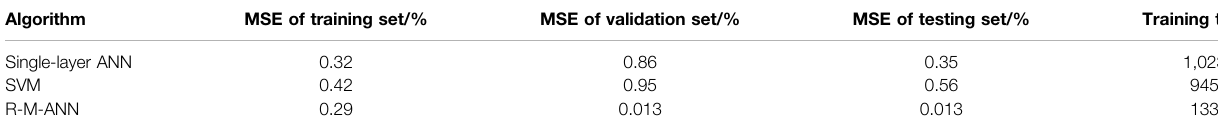
TABLE 3 | Comparison of three machine-learning techniques for the 4-generator 2-area system. Algorithm MSE of training set/% MSE of validation set/%